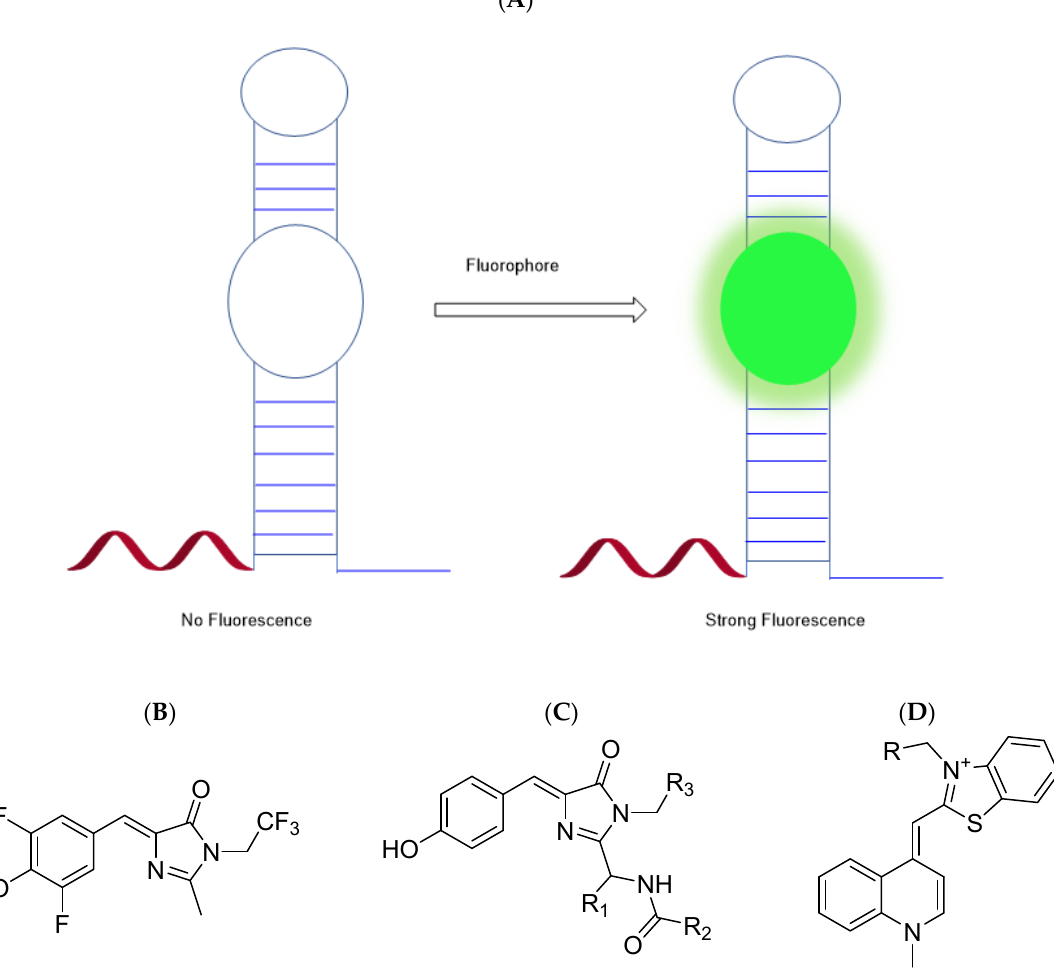
Figure 3. ( A ) Scheme of the aptamer–RNA complex lit up by a fluorophore. Typically, Broccoli binds to DFHBI–1T (GFP fluorophore mimic) and Mango uses TO1–biotin to activate fluorescence. ( B ) Structure of DFHBI–1T. ( C ) Structure of GFP fluorophore (for comparison). Since the flourophore is part of the larger GFP protein complex, R1, R2, and R3 correspond to serine 65, a methyl group, and glycine67 residues from the protein respectively. ( D ) Structure of TO1–biotin. R represents the biotin-polyethyleneglycol (PEG)-linker [25,26].